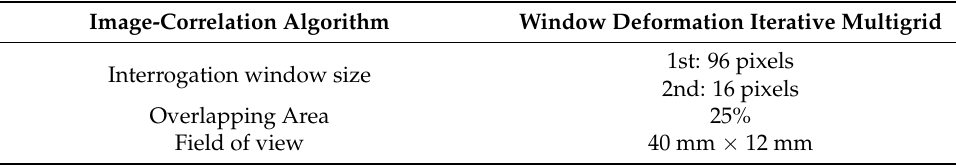
Figure 5. Experimental setup for the PIV measurement system. Table 1. Conditions for calculating the velocity field. Table 1. Conditions for calculating the velocity field.